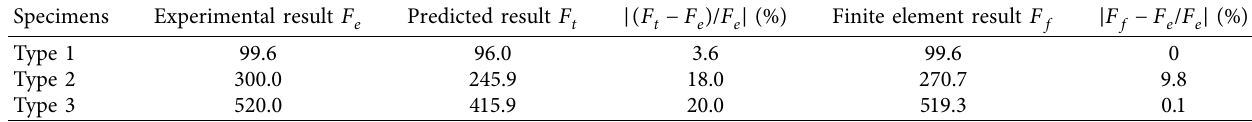
Table 5: Comparison of experimental results, predicted results, and finite element results (unit: kN).